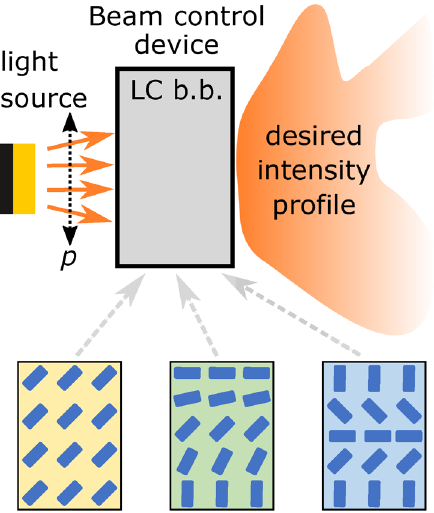
Figure 1. Schematic view of a liquid crystal (LC) beam control device. The device is composed of a single or stacks of LC building blocks (LC b.b.) with some examples shown below. Blue cylinders represent nematic director and p shows the polarization of the incoming light. The desired light profile is defined by locally tunable birefringent structure in the LC building